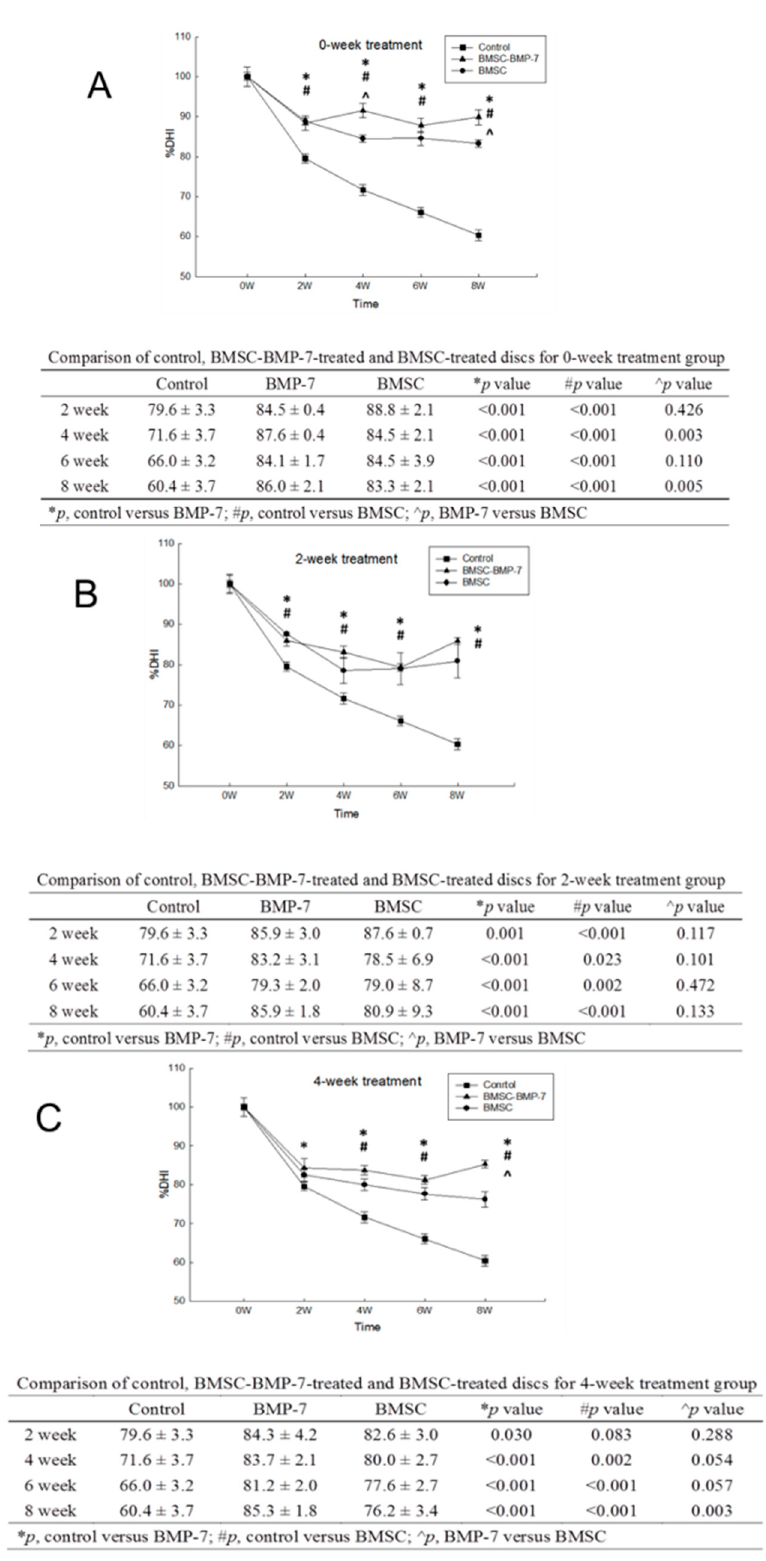
Figure 2. ( A ) Zero-week treatment group. The ratio disc height change at different methods (control, BMDMSCs, Baculo-BMP-7-BMDMSCs) and time points. The Baculo-BMP-7-BMDMSC could maintain better disc height; ( B ) two-week treatment group. Comparing to the control subgroup, BMMSCs and , Baculo-BMP-7-BMDMSCs could sustain more disc height; ( C ) four-week treatment group. There was still a trend that the Baculo-BMP-7-BMDMSCs subgroup had more ability to slow down disc-narrowing induced by disc puncture.